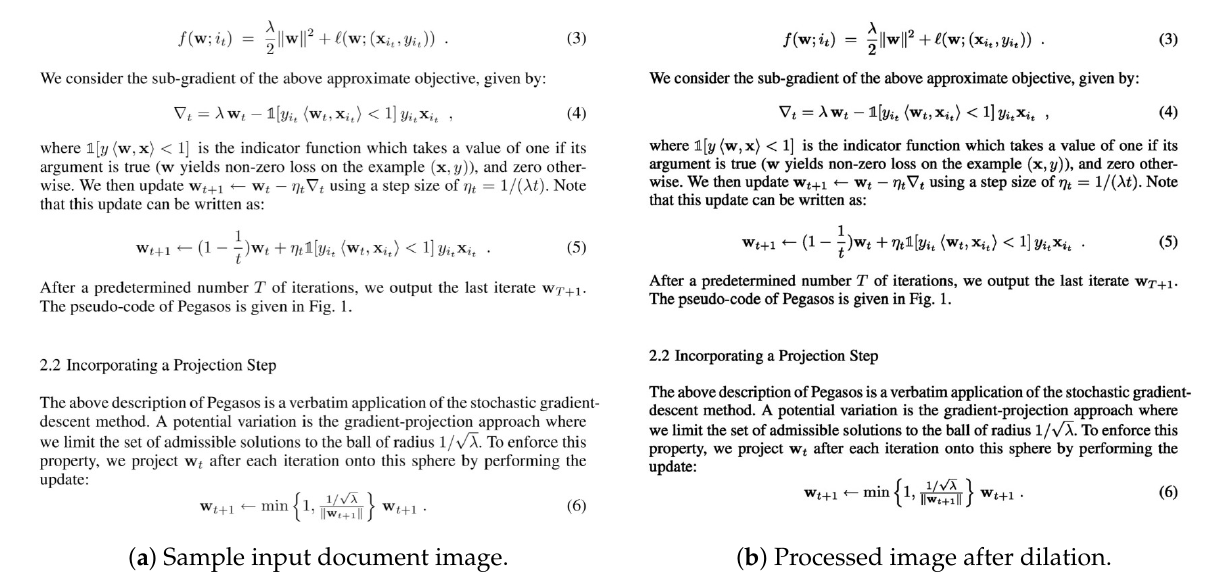
( a ) Sample input document image. Figure 6. Visual comparison of a document image before (shown in ( a )) and after the pre-processing method (depicted in ( b )). The dilation process facilitates our feature extraction network by increasing the boundaries of foreground pixels, reducing the number of background pixels.